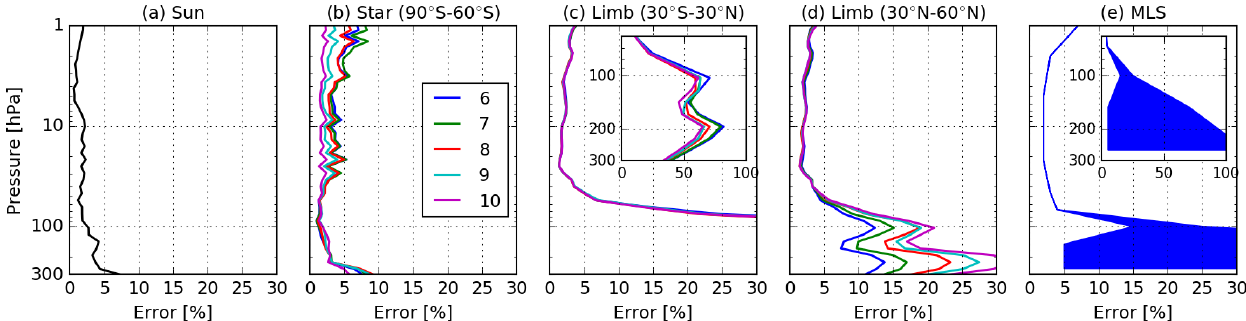
Figure 7. Typical simulated ALTIUS ozone error standard deviation profiles (%) for solar (a) and stellar occultations (b) and bright limb (c, d) . The colour code indicates the month number. Stellar occultation error standard deviation profiles correspond to the 90–60 ◦ S bin. For bright limb, error profiles correspond to the 30 ◦ S–30 ◦ N (c) and 30–60 ◦ N (d) latitude bins, both for the same 30–60 ◦ sza bin. For comparison, MLS single profile precision error standard deviations taken from Livesey et al. (2020) are shown in panel (e) with a range of min/max values below 68hPa. A zoom-in of the tropical tropopause layer is shown in panels (c, e) .